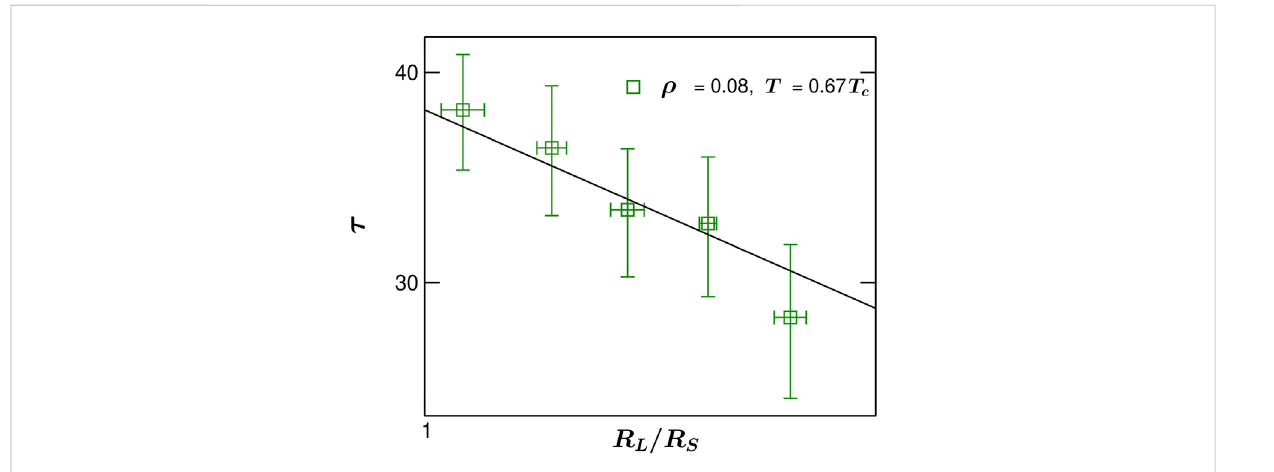
Same asFigure4,but fordensity ρ =0.08 andtemperature T =0.67 T c .Symbolscorrespondto molecular dynamicssimulationdata andthesolid line is a fi t to that with n ≃